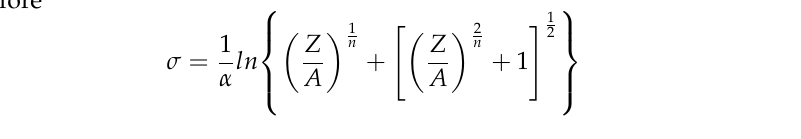
modified constitutive equation, x is the average values of flow stress in experimental, y is predicted flow stress, N is total number of collected stress, and R is a statistical index, which reflects the correlation quality between different variables. Additionally, AARE is the average absolute value of related error, which is an impartial statistical index for testing the predictability of the equation. The results are confirmed in Figure 9. Figure 10 reflects the fit of the experimental flow stress to the predicted flow stress. The values of R 2 (R) and AARE were 0.979 (98.94%) and 6.883% by Equations (26) and (27). This indicates that the two flow stresses had good coherence. It shows that the modified constitutive equation had good prediction ability. Figure 10. Fitting relationship between experimental and predicted flow stress. 3.6. Microstructure Analysis